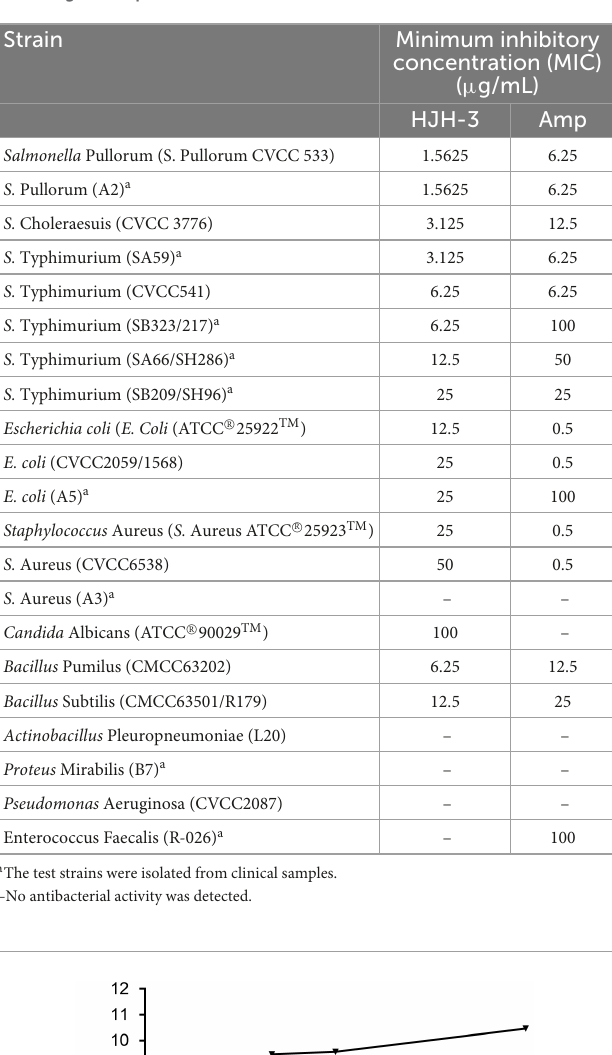
TABLE 2 Minimum inhibitory concentration (MIC) test results of AMP HJH-3 against representative strains.